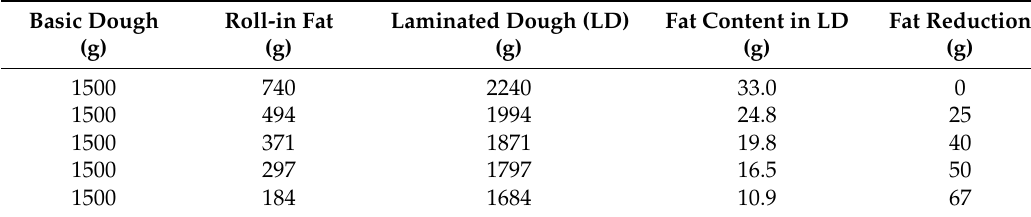
Table 1. Used roll-in fat and fat content in laminated dough